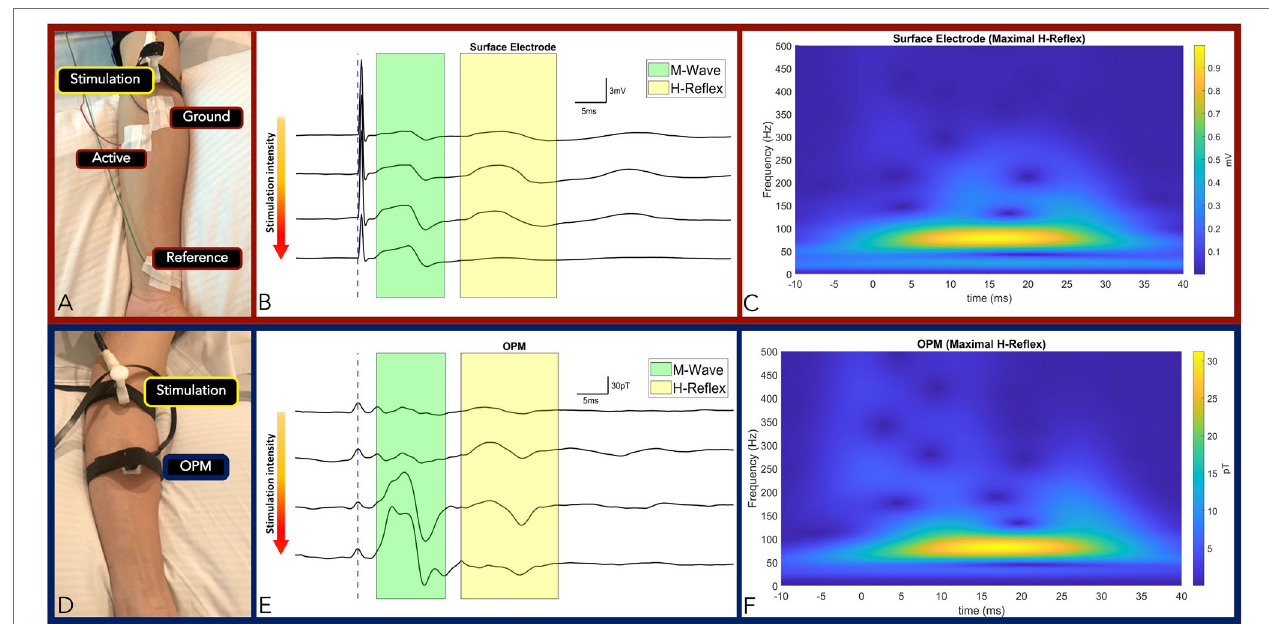
FIGURE 2 | Panel (A,D) : Measurement setup of FCR M-wave and H-Reflex responses measured by surface electrode (A) and OPM (D) from the same subject. Panel (B,E) : Time-locked averages with incremental increase in stimulation intensity from top to bottom traces by surface electrode (B) and OPM (E) . The M-wave and the H-Reflex responses are highlighted green and yellow, respectively. Conserved standard M and H-Reflex characteristics: (1) M-wave amplitude increased incrementally until a maximum was reached, while (2) H-Reflex amplitudes increased incrementally before reaching a maximum and subsequently decreasing and subsequently decreasing, were observed in all measurements (surface electrodes in B and OPM in E). Panel (C) : Surface electrode time-frequency analysis of FCR M-wave and maximal H-Reflex recorded. Panel (F) : OPM time-frequency analysis of FCR M-wave and maximal H-Reflex recorded. (OPM, Optically pumped magnetometers, FCR, Flexor carpi radialis, mV, millivolt, pT, picoTesla, ms, milliseconds, and TF, Time